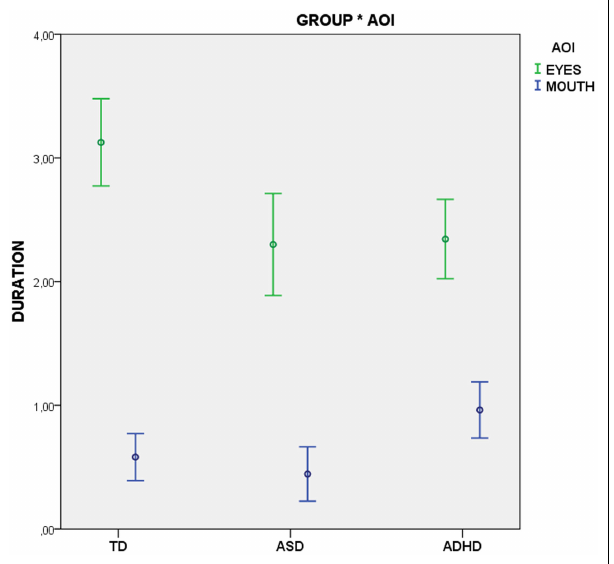
TABLE 2 | Summary of GLMM model examining total fixation time as a function of IVs group, type of facial stimulus, and area of interest with age and sex as control IVs .